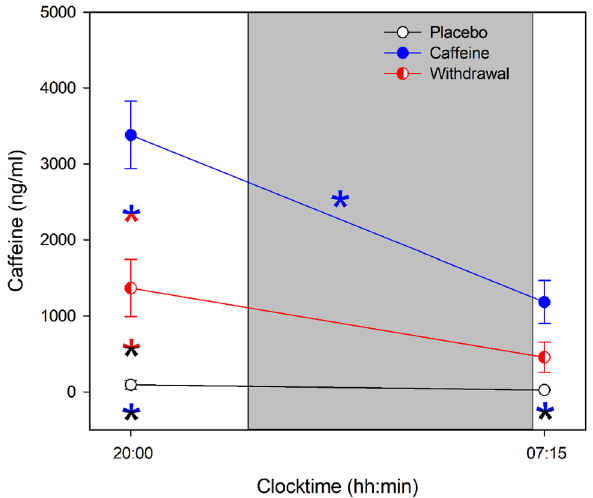
Figure 1. Average caffeine levels collected prior to and after nighttime sleep (grey bar) in the placebo (black open circles), caffeine (blue filled circles), and withdrawal (red semi-filled circles) condition (mean values ± standard errors). The x-axis indicates the mean time of day of sample collection and color-coded asterisks represent significant ( p < 0.05) post-hoc comparisons of the interaction effect condition ×